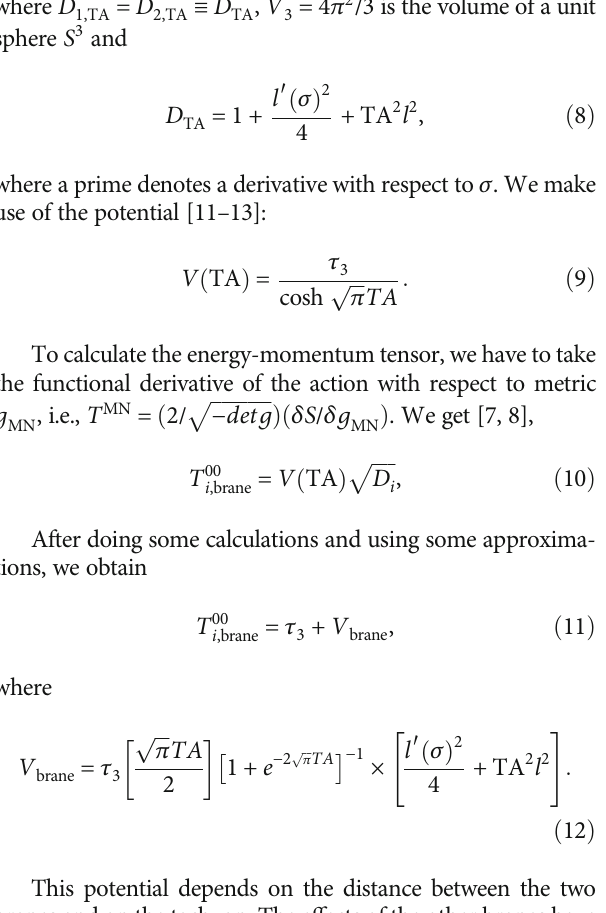
Figure 1: Pair of D 3 - (cid:1) D 3 -brane pairs at z